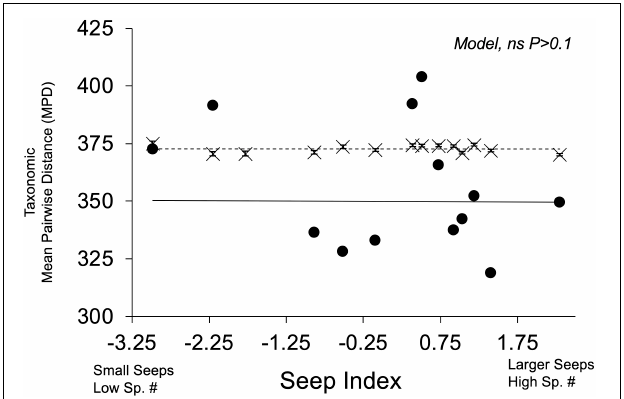
FIGURE 5 | Comparison of observed and null mean phylogenetic distances (MPDs) across seep index. Observed seep values are represented by black circles ( ) and solid line; randomly generated null communities are represented by “X” markers and dashed line. Error bars present on null MPD (cid:32) community values represent 95% confidence